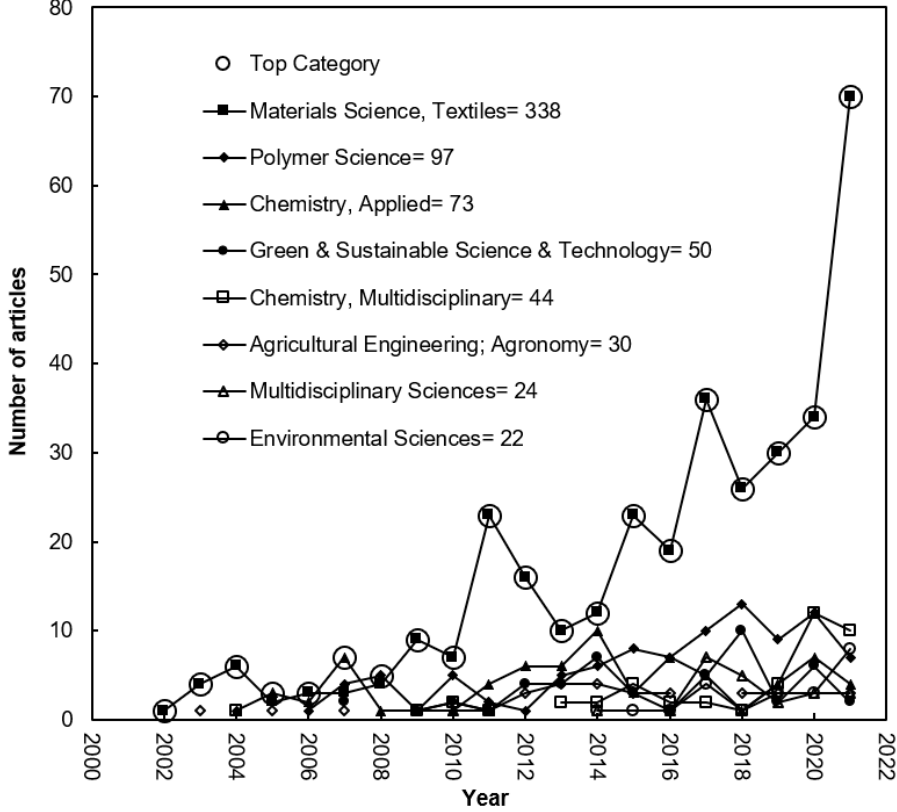
Figure 2. Developments of the top nine Web of Science categories.